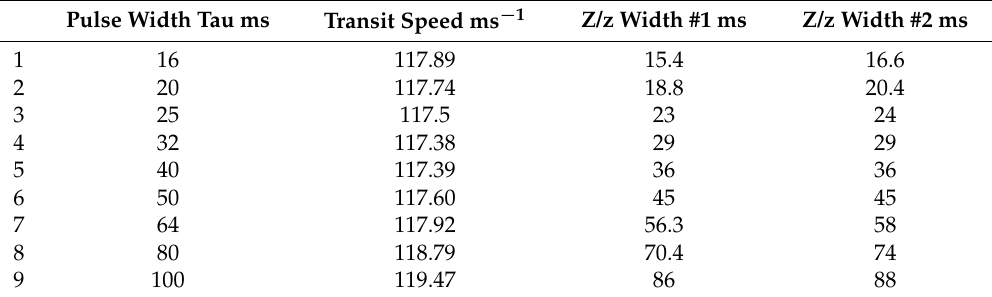
Table 2. Wavelet properties taken from runs with different Ricker drive pulse